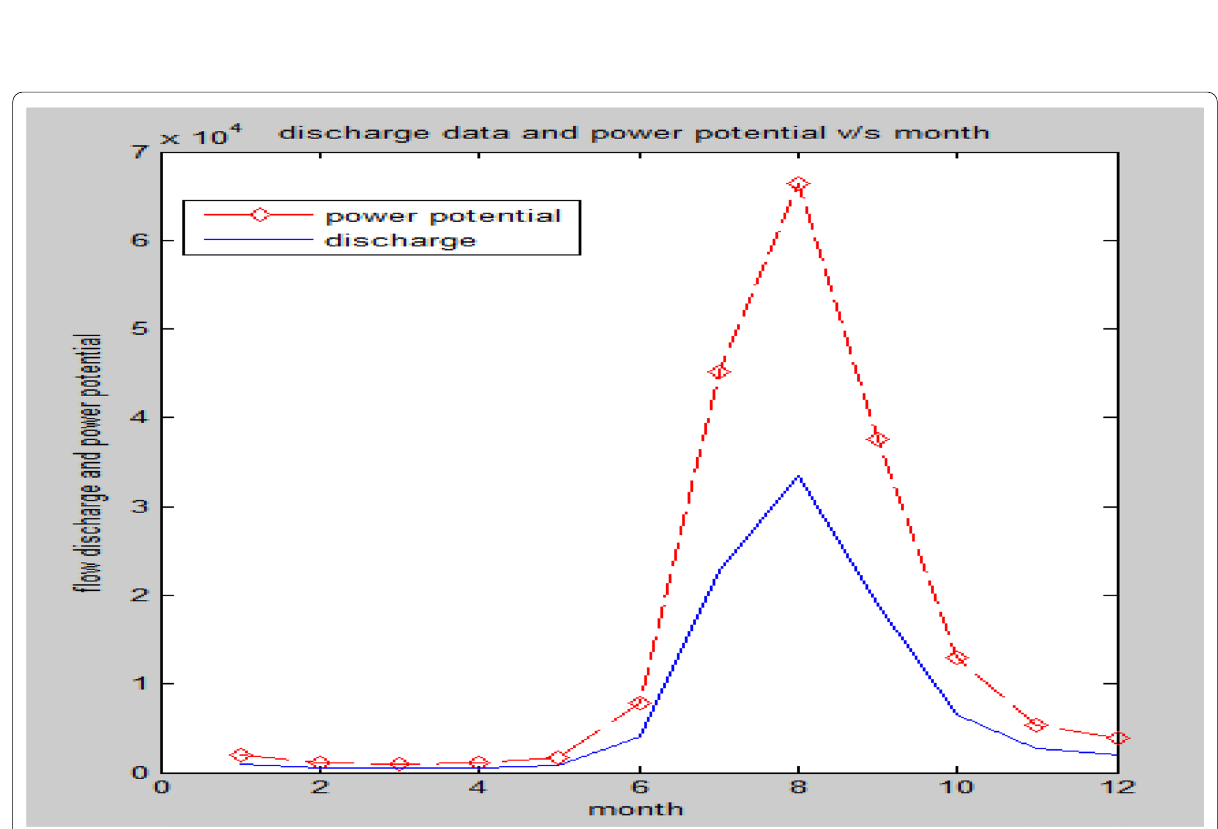
Fig. 4 Curve of power potential and monthly flow release (Fritz